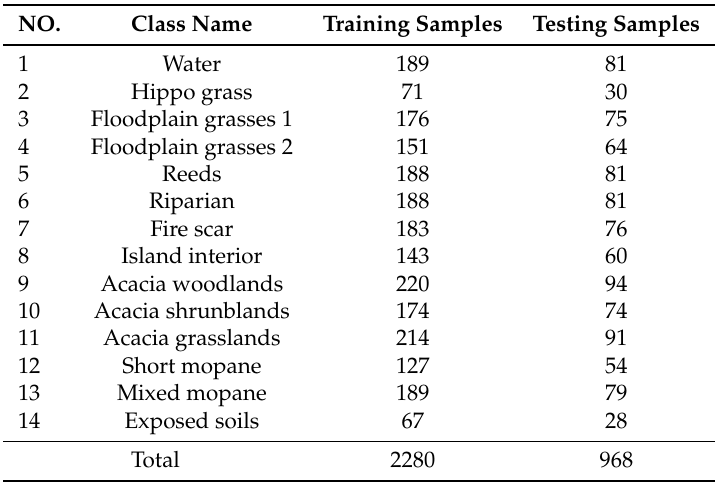
Figure 6. Botswana Scene dataset. ( a ) Three-band false-color composite. ( b ) Ground-truth map. Table 2. Sample size for Botswana